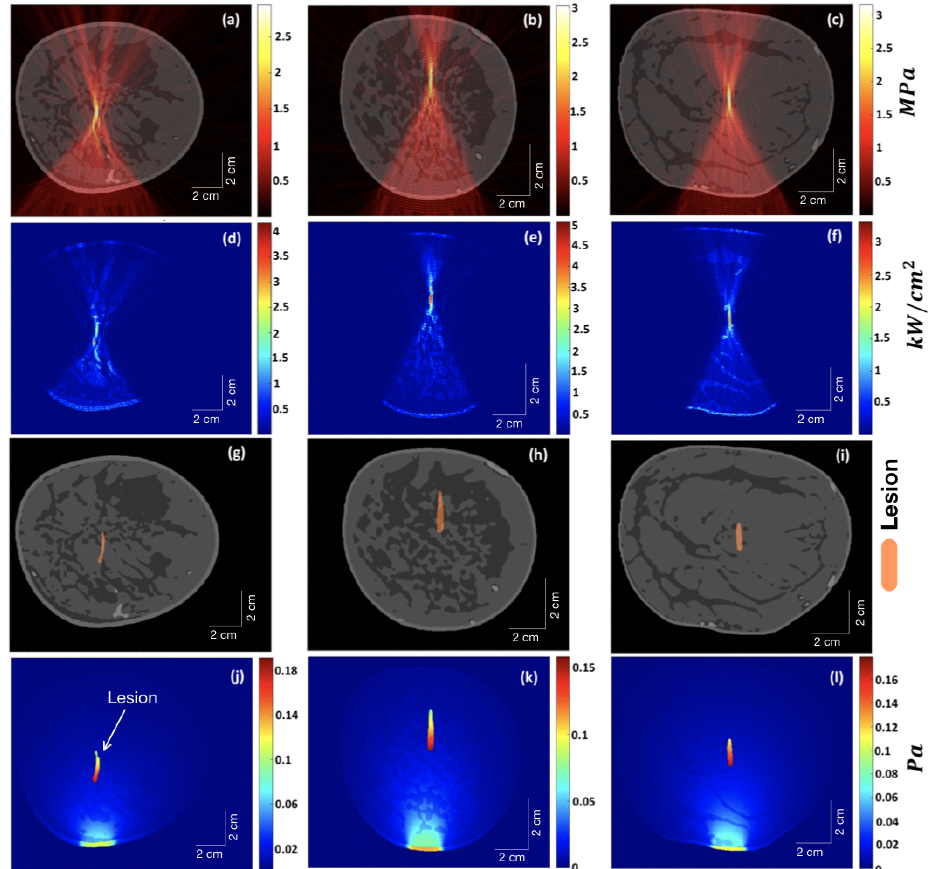
Figure 5. The first column ( a – j ) corresponds to the extremely dense-type breast, the middle column ( b – k ) corresponds to the heterogeneously dense-type breast, and the last column ( c – l ) corresponds to the scattered fibroglandular-type breast. The top row ( a – c ) shows the distribution of HIFU pressure wave amplitude overlayed on the respective breast type. The second row ( d – f ) shows the distribution of the heat deposition rate per unit area. The third row ( g – i ) shows the lesion map overlayed on the respective breast type. The bottom row ( j – l ) shows the initial pressure ( P 0 ) distribution for the induced lesion using